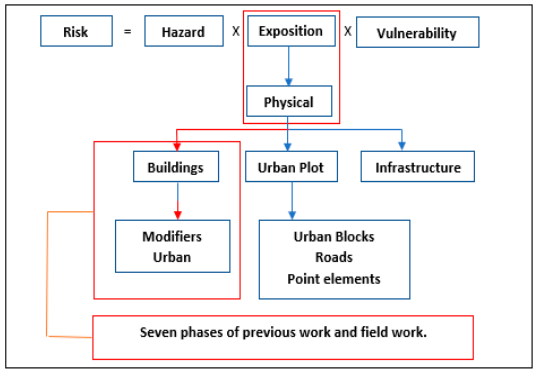
Figure 2. Phases of the study. Source: Own